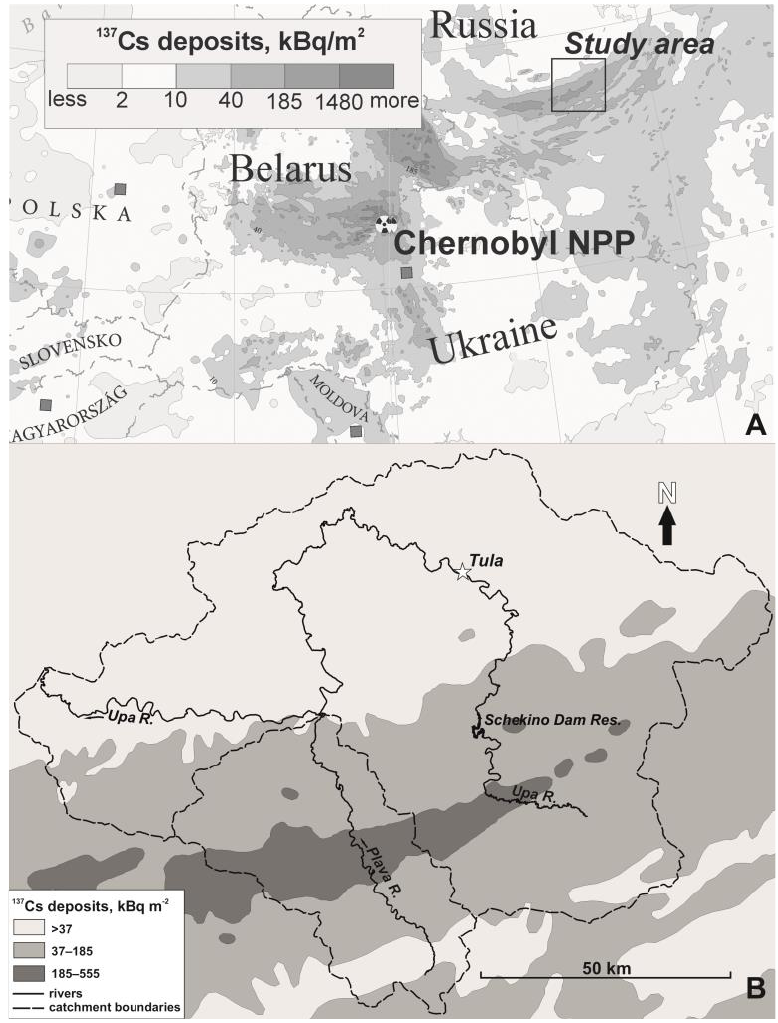
Figure 2. ( A ) Location of study area within Chernobyl-affected area [92]; ( B ) radioactive contamina- tion along Upa River.